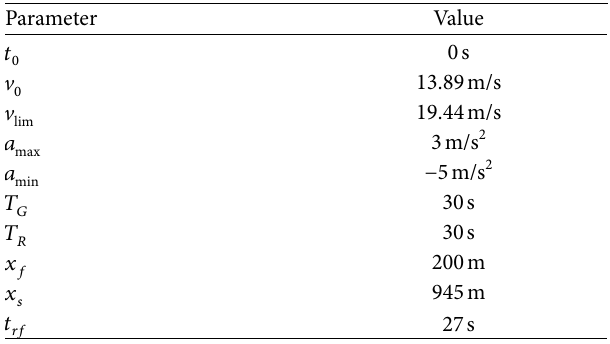
Figure 5: Experiment and simulation environment. Table 2: Simulation parameters during once optimization. Table 4: Simulation parameters in rolling optimization.